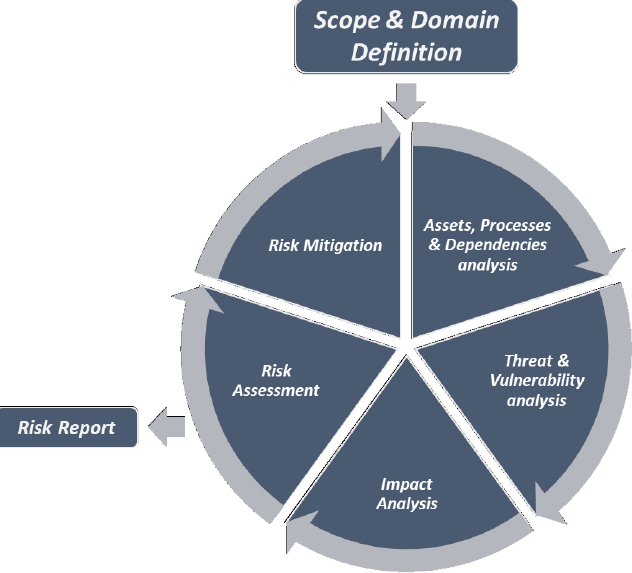
Figure 2. Structural view of the APSIA (Automated Privacy and Security Impact Assessment)